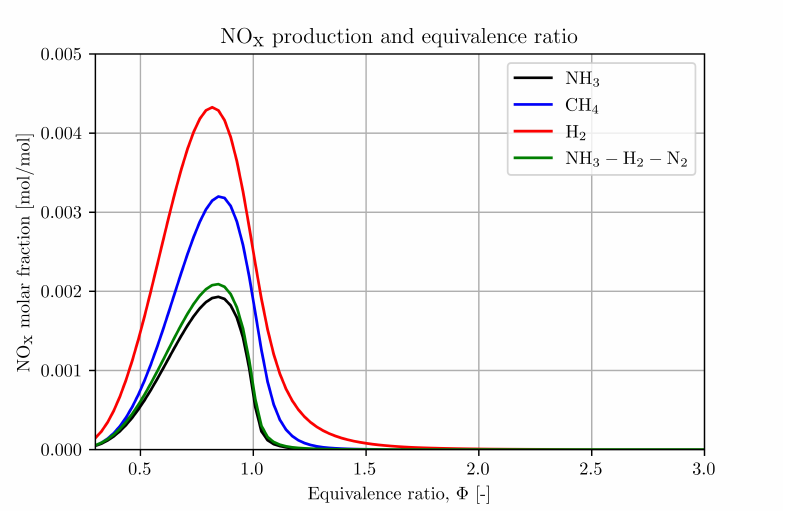
Figure 7. The NOx molar fraction at various equivalence ratios for pure methane, ammonia, and hy- drogen, each burning in dry air. The results represent chemical equilibrium in a well-stirred reactor. Methane combustion is modelled using the GRI-Mech 3.0 mechanism [57]. Ammonia and hydrogen combustion is modelled using the Stagni et al. [21] combustion